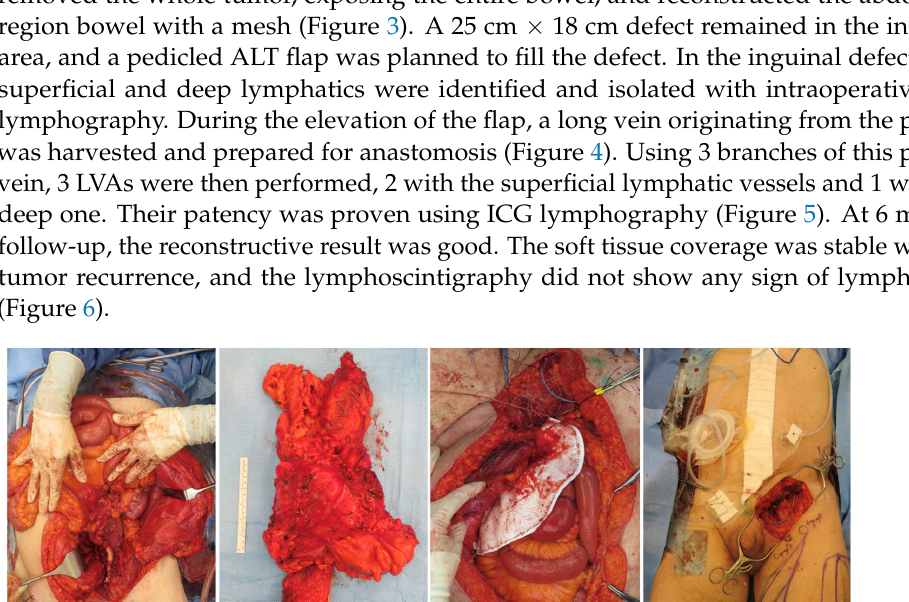
Figure 5. ( A ) Lymphovenous anastomoses of 2 superficial lymphatics and 1 deep lymphatic with 3 branches of the pedicle vein. ( B ) Intraoperative ICG lymphography to confirm the patency of the anastomoses. ( C ) Picture of the groin at the end of the procedure: the ALT flap was inset and 3 LVAs were performed with 3 pedicles branches.